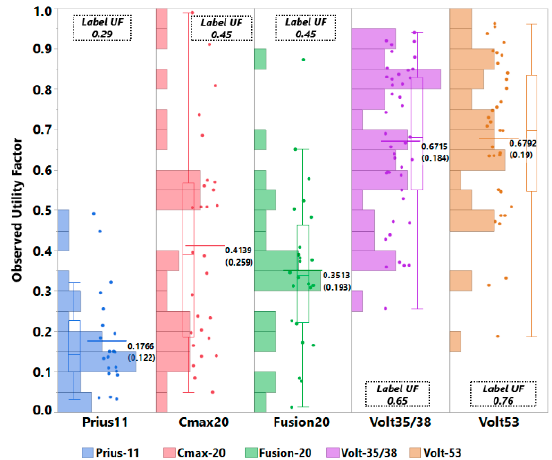
Figure 1 . Distribution of individual Utility Factor (UF) by PHEV model. Average and standard deviation of UF is indicated within parentheses. EPA label city/highway combined UF is shown inset.